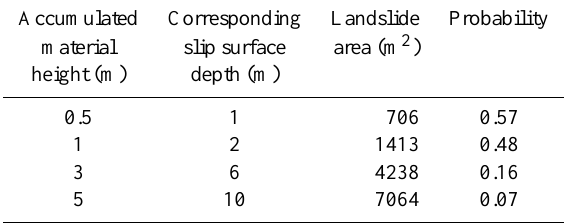
Table 4. Magnitude probability of slides according to the height of their accumulated material in the Loures